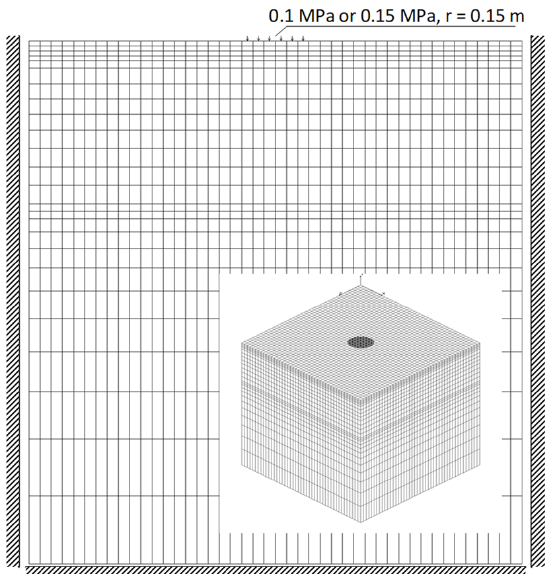
Figure 9. Calculation model of the subgrade layer system.